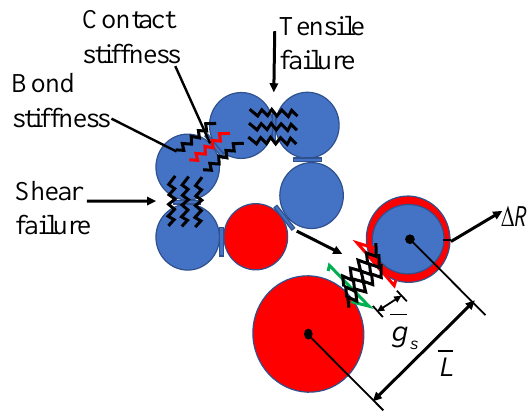
Figure 5. Heat conduction diagram.